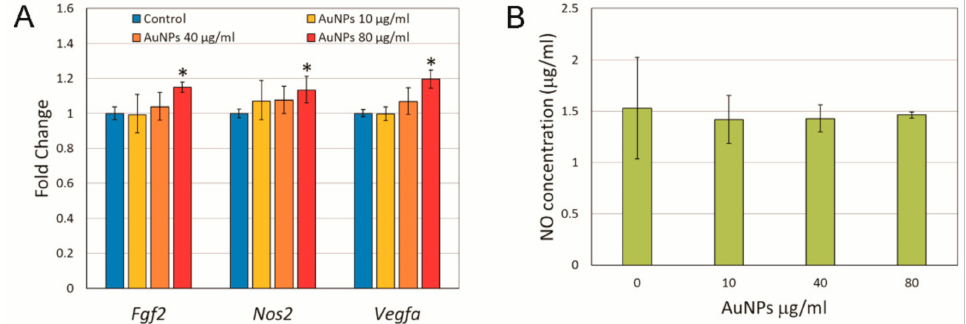
Figure 4. Cellular expression of Fgf2, Nos2 and Vegfa at mRNA level ( A ) and NO concentration ( B ) in cell culture medium after treatment of 4T1 cells with AuNPs in vitro for 6 h. Data are expressed as means and 95% confidence intervals from four independent experiments. * p < 0.05 difference versus control